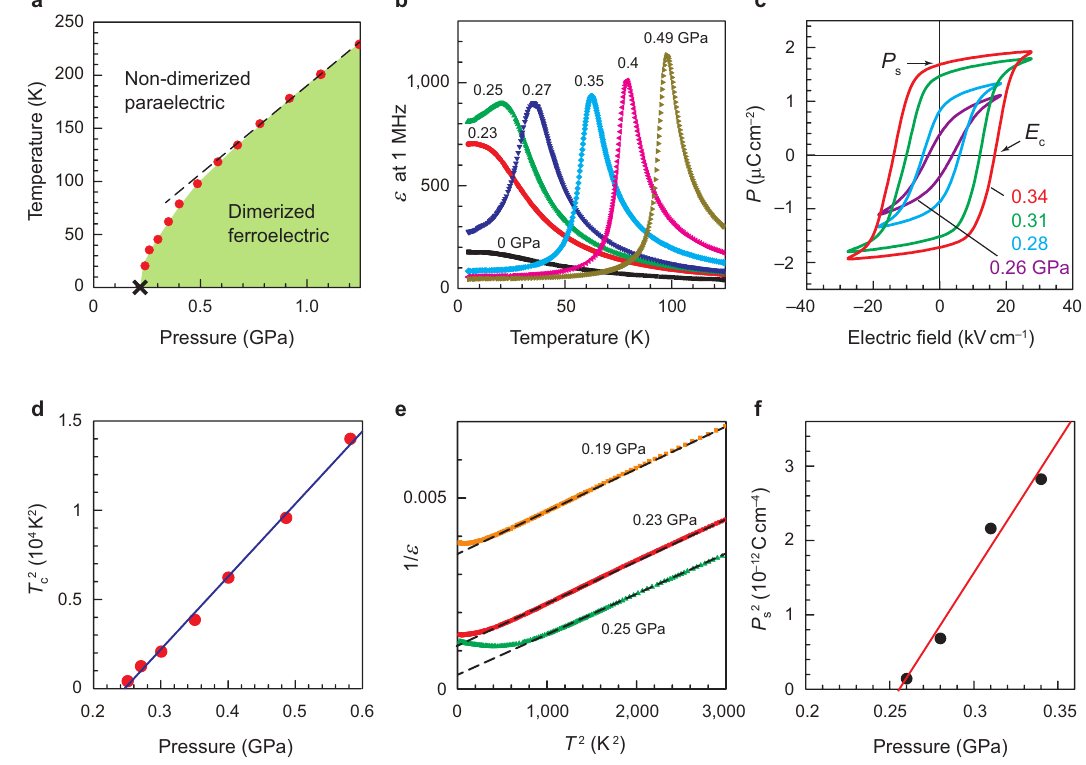
Figure 2. ( a ) Pressure–temperature phase diagram of TTF-2,5-QBr 2 I 2 . ( b ) Temperature dependence of the permittivity under various pressures. The applied pressure value, corrected considering its thermal change in the medium for each measurement, is represented by the value at the transition point or at the lowest temperature when the phase transition is absent. ( c ) Pressure variations in the polarization hysteresis loop measured at the lowest temperature: T / T c = 0.1 for 0.28, 0.31 and 0.34 GPa, and T / T c = 0.3 for 0.26 GPa. ( d ) T 2 c versus pressure plot, highlighting the quantum critical behavior of the ferroelectric-transition temperature. The blue line represents T c ∼ ( p − p c ) 0.5 with p c ≈ 0.25–0.26 GPa. ( e ) Inverse permittivity versus the square of the temperature. The broken lines represent 1/ (cid:101) ∝ T 2 . ( f ) P 2 s versus pressure plot, highlighting the quantum critical behavior of the spontaneous polarization. The red line represents P s ∼ ( p − p c ) 0.5 with p c ≈ 0.25–0.26